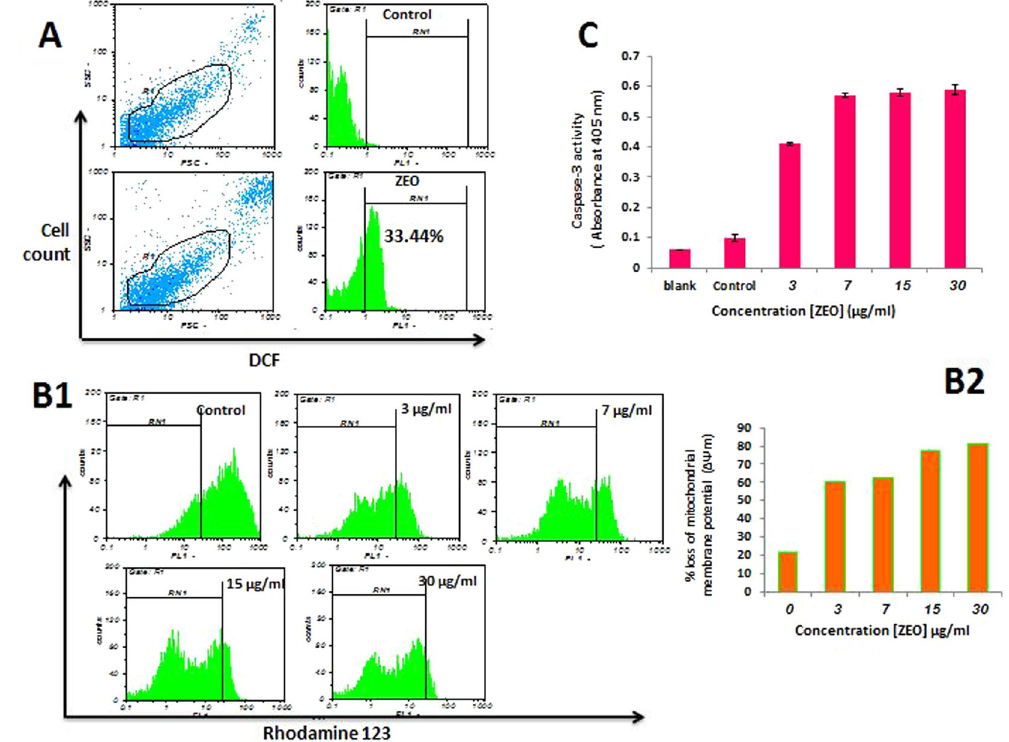
Figure 5. ZEO induces ROS production in MDA-MB-231 cells. ( A ) ROS level in MDA-MB-231 cells were estimated after incubation with IC50 concentration of ZEO using DCFH-DA dye and flow cytometer. ( B1 , B2 ) The collapse of mitochondrial membrane potential. The ΔΨ m of MDA-MB-231 cells reduces increasingly after incubation with 0–30 μ g/ml ZEO for 12 h, as assessed by Rhodamine123 staining and FACS analysis. ( C ) caspase-3 Activation assessment after 4 h treatment with ZEO (3–30 μ